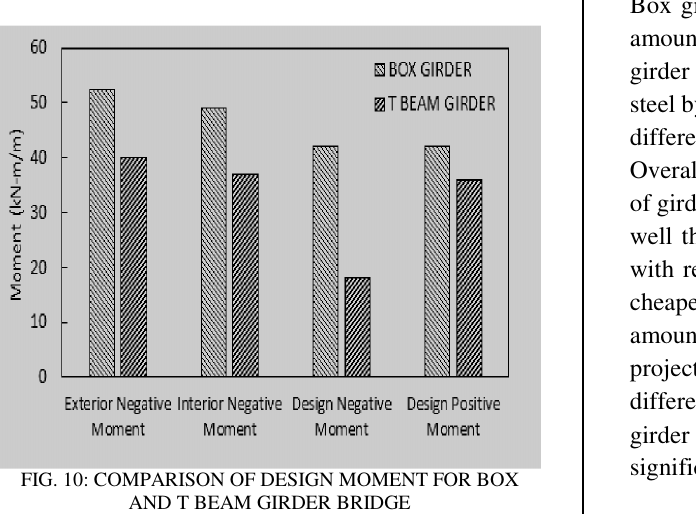
FIG. 9: COMPARISON OF MAXIMUM SHEAR FOR SLAB DESIGN FOR BOX AND T BEAM GIRDER